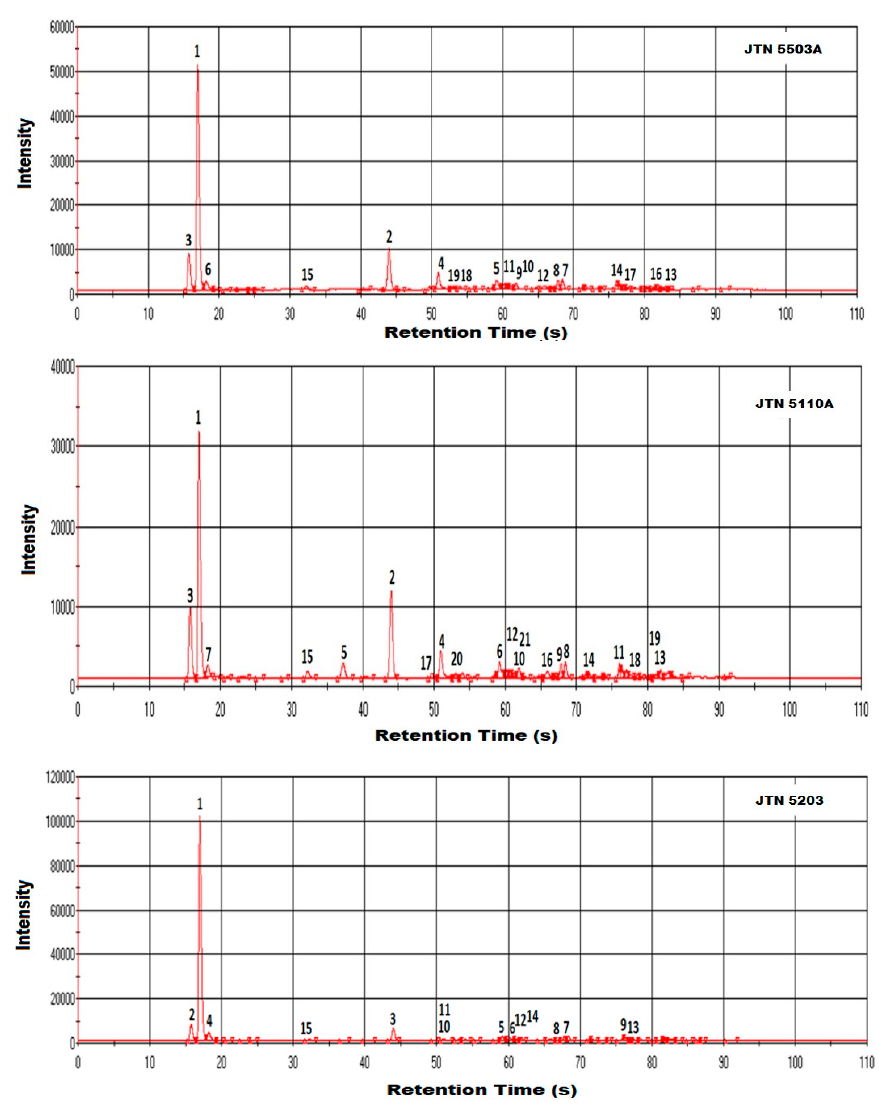
Biosensors 2019 , 9 , x FOR PEER REVIEW Figure 4. Ultra-fast GC Chromatogram of soybean varieties: JTN5503, JTN5110, JTN5203.